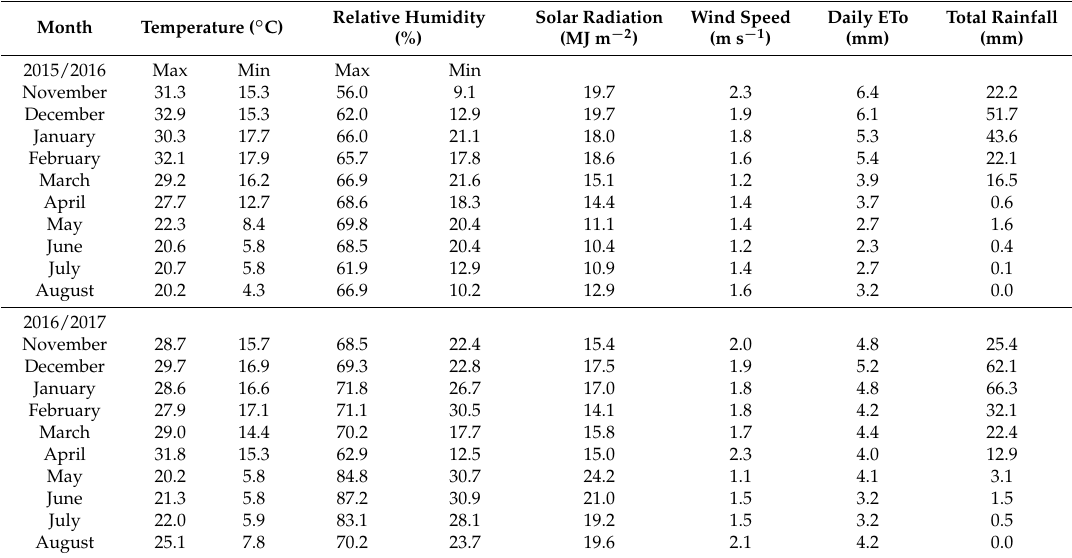
Table 3. Monthly mean weather data for an automatic weather station at the Hatfield Experimental Farm. Month Temperature ( ◦